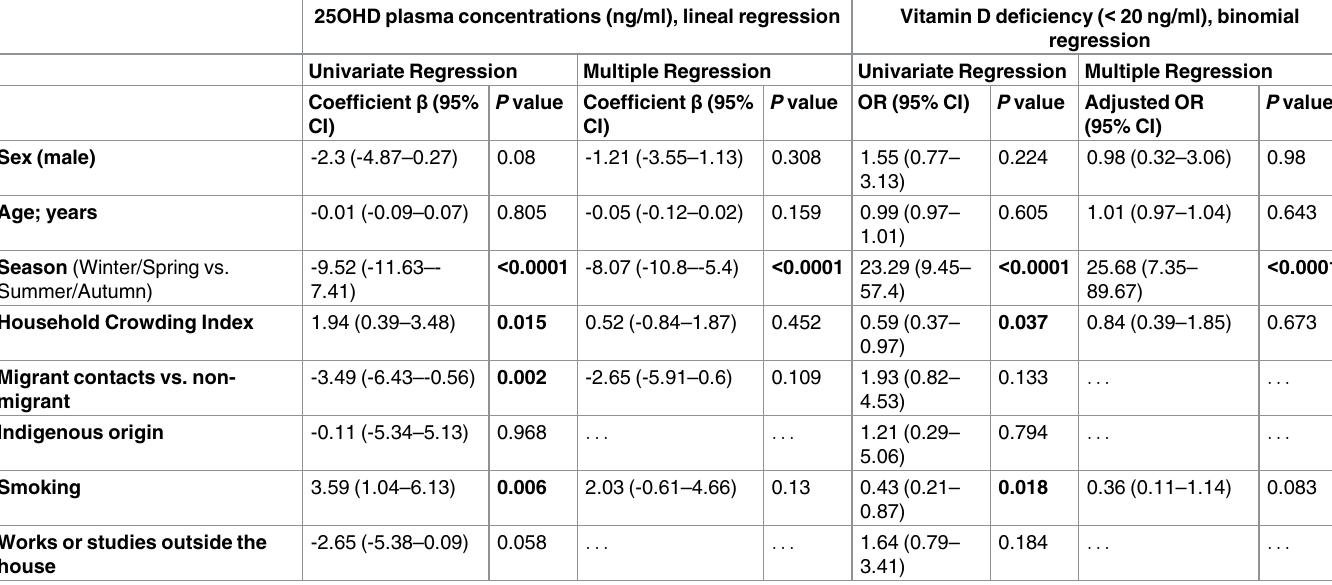
Table 3. Regression Analysis of associations with Vitamin D levels among all TB household contacts (n = 139).